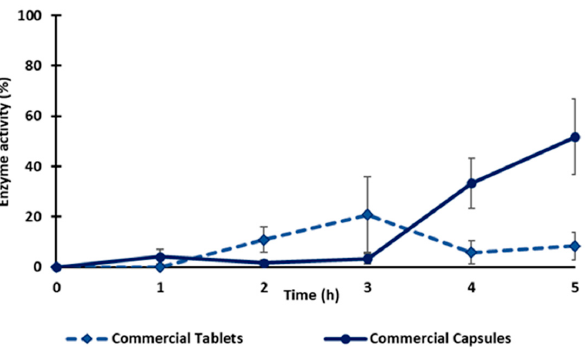
Figure 7. Release profile of vDAO from two commercial products (tablet and capsule forms). Tablets